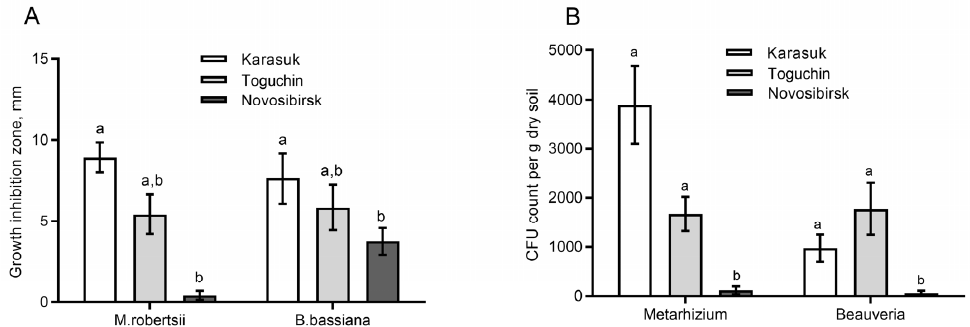
Figure 1. Antagonistic effects of soil extracts from soils of kitchen potato gardens (Karasuk and Toguchin) and from a conventional potato field (Novosibirsk) on fungi M. robertsii and B. bassiana ( A ) and on fungal CFU counts in these soils ( B ). Different letters indicate significant differences between soils for each fungus (Dunn’s test p < 0.05).